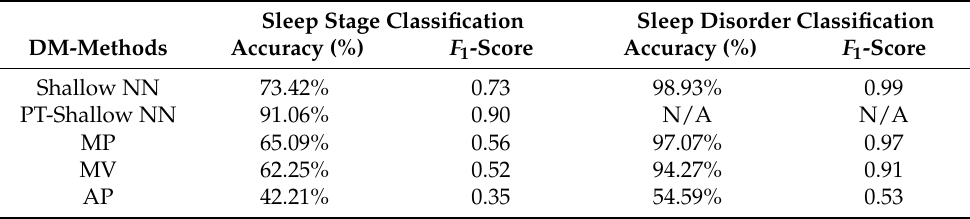
Table 5. Experiment 2: Classification results for MML-DMS1 with different final decision-making